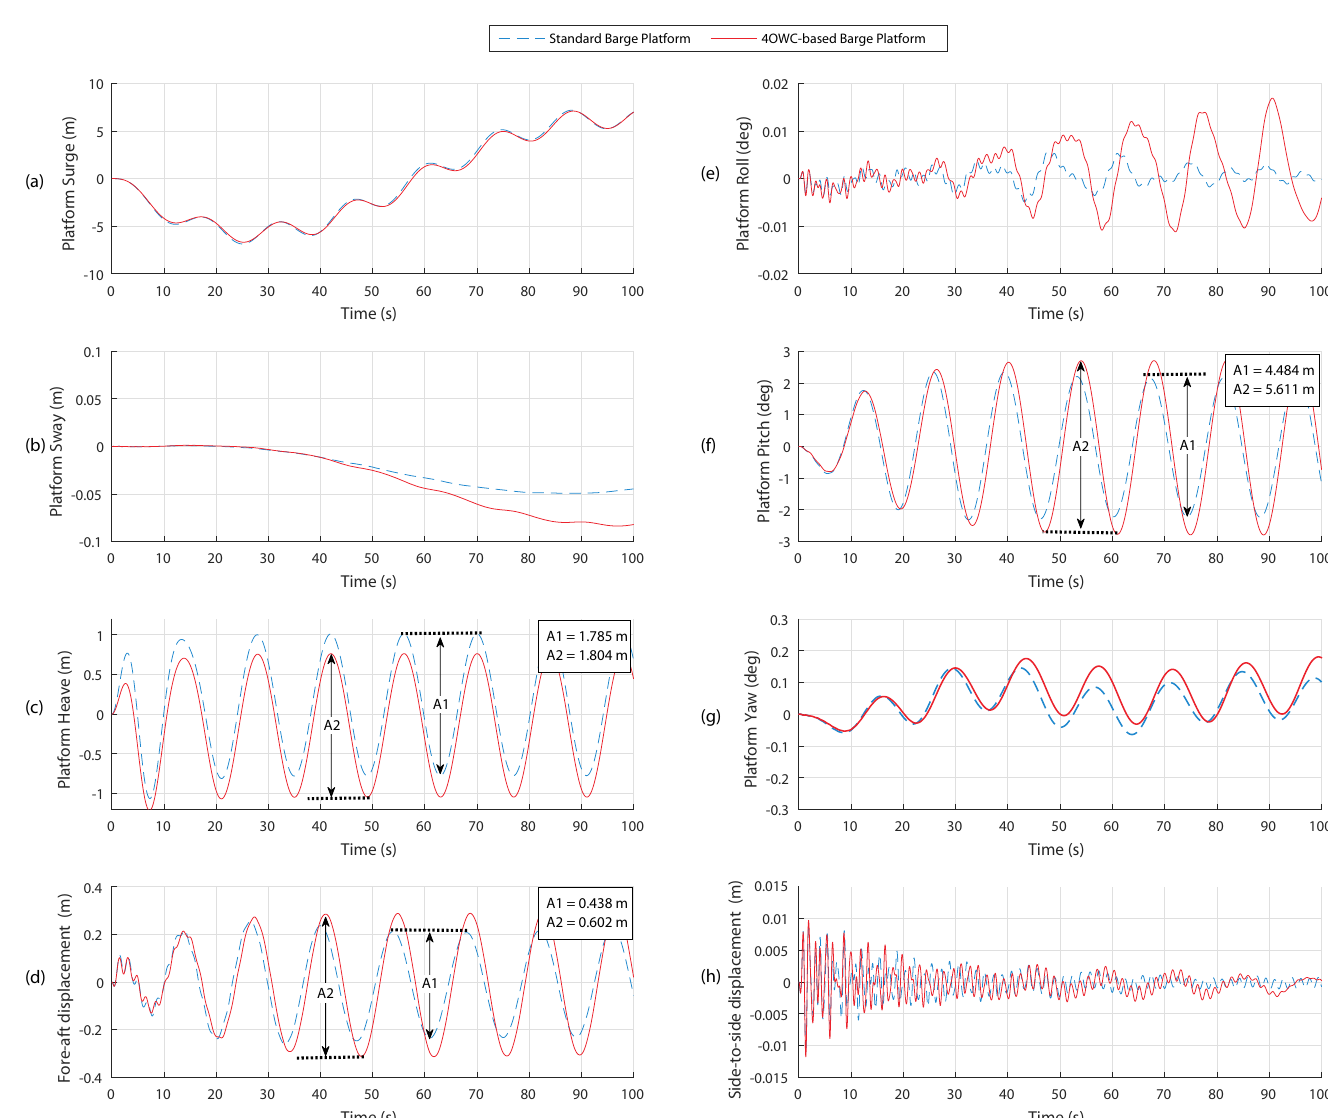
Figure 12. Platforms’ modes for ( a ) Surge. ( b ) Sway. ( c ) Heave. ( d ) Fore-aft. ( e ) Roll. ( f ) Pitch. ( g ) Yaw. ( h )